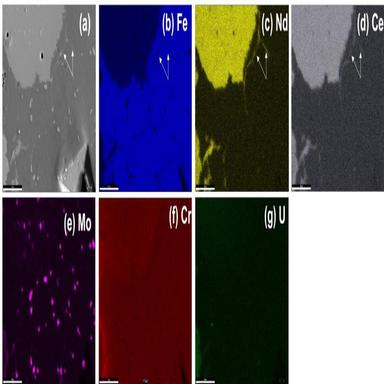
SEM image and EDS mapping showing the microstructure and composition of a selected region with observable GB infiltration. Scales bars of 10 μm are shown. (a) shows a SEM image of the selected area. (b)–(g) shows the raw intensity map of individual elements, Fe, Nd, Ce, Mo, Cr, and U, respectively.